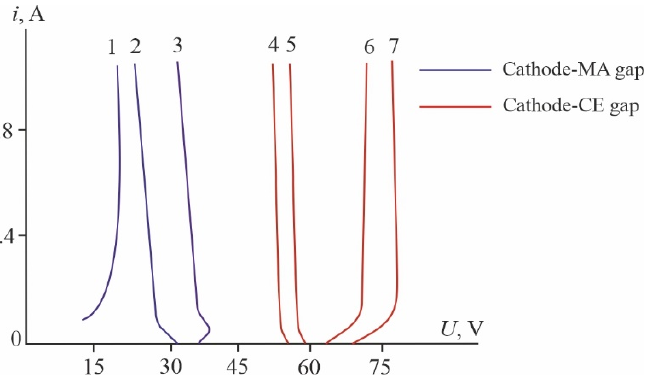
Figure 5. Current-voltage curves of the different gaps, registered at different helium pressure values P He , Torr: 1–0.9; 2–0.3; 3–0.1; 4–1; 5–0.8; 6–0.6;